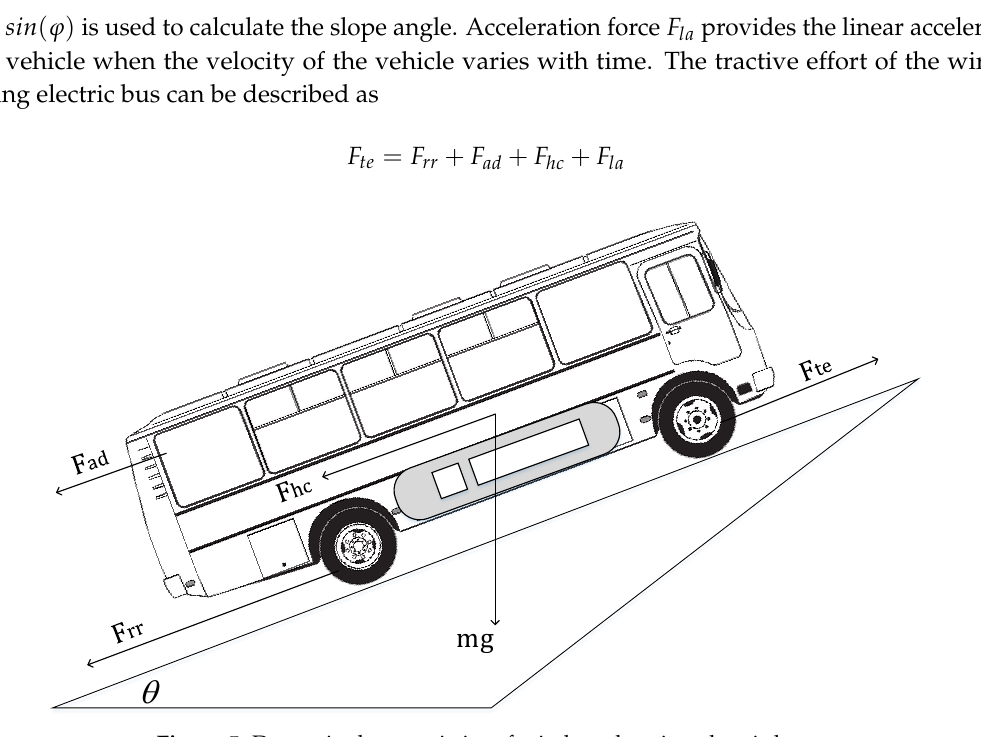
Figure 5. Dynamic characteristics of wireless charging electric